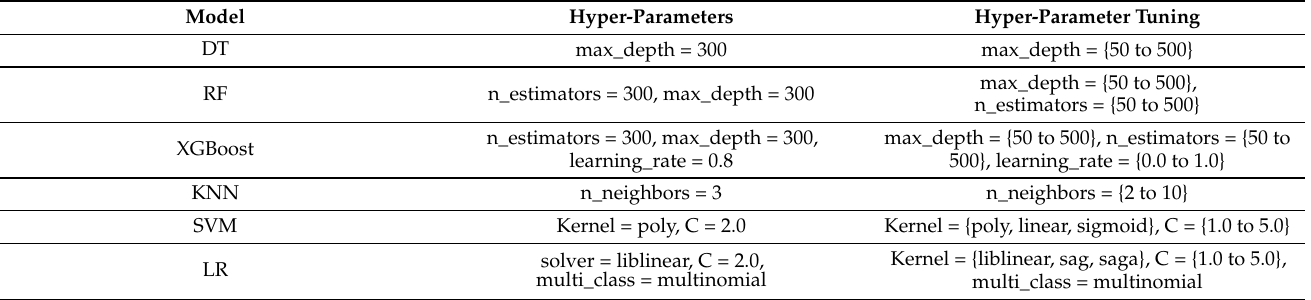
Table 11. Machine-learning model hyper-parameter settings.